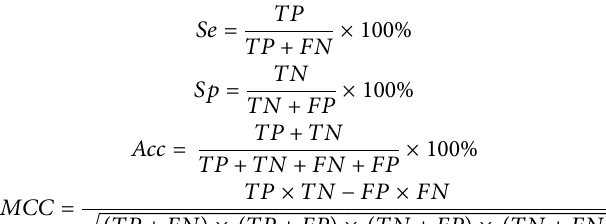
The best Acc values to re fl ect the performance of different classi fi ers were highlighted in bold font.